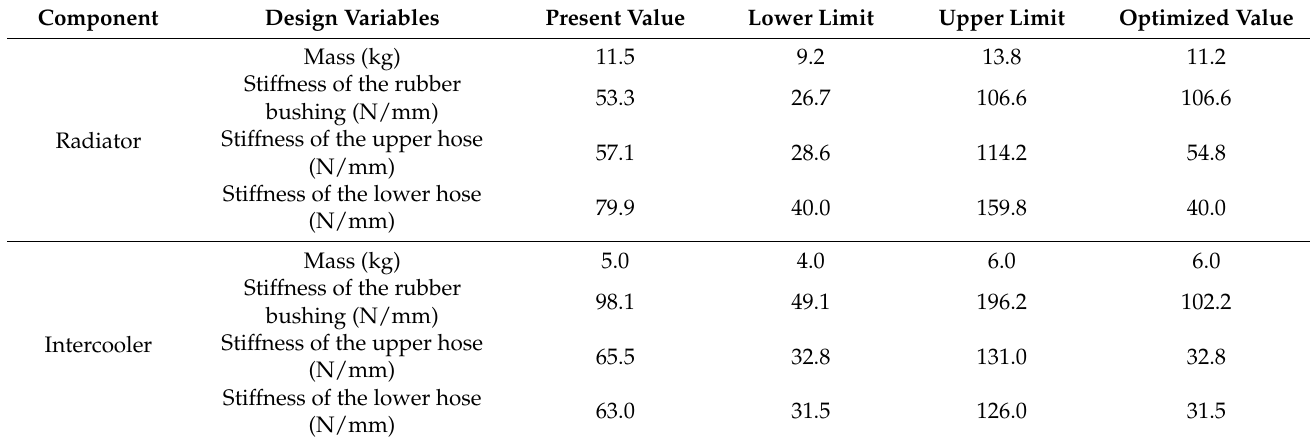
Table 4. Present values, the lower and upper limits, and optimized values of the design